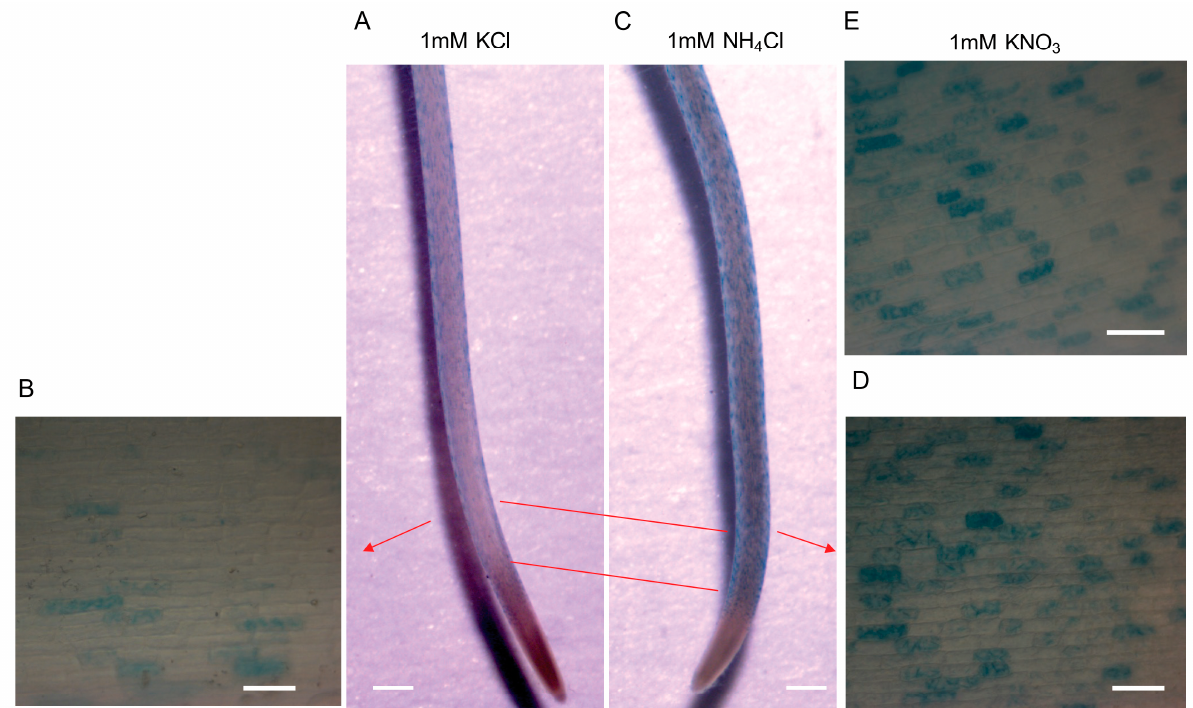
Figure 6. GUS patterns in CSLD1::Ds/CSLD1::Ds ( csld1 ) roots in different nutrient supplementations. ( A ) The GUS staining of the whole seminal root supplemented with 1 mM KCl and ( B ) 100 × magnification of KCl-treated seminal root trichoblast cells. ( C ) Staining of seminal root supplemented with 1 mM NH 4 Cl and ( D ) 100 × magnification of NH 4 Cl-treated seminal root trichoblast cells. ( E ) 100 × magnification of KNO 3 -treated seminal root trichoblast cells. Red bars indicate the root sections which were used to capture magnified images. Scale bars: A , C ; 500 µ m and B , D , E ; 50 µ